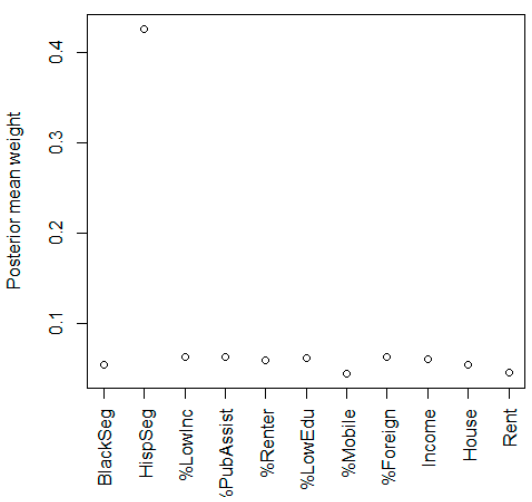
Figure 1. Posterior mean weights for variables in the crude model of neighborhood deprivation index for childhood leukemia. Note: components are Black segregation, Hispanic segregation, ratio of income to poverty < 1, percent receiving public assistance income, percent of renters, percent with no high school diploma, percent in a different house than 1 year ago, percent foreign born, per capita income, median house value, and median gross rent. Table 1. Odds ratios and 95% credible intervals for the covariate-adjusted neighborhood deprivation index (NDI) model for childhood leukemia.